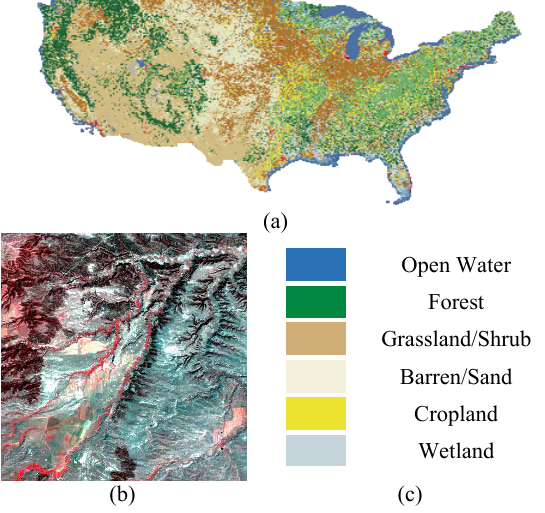
Figure 2. (a): Land cover types in NLCD2001 database; (b) and (c): an ETM+ image and six land covers of the test